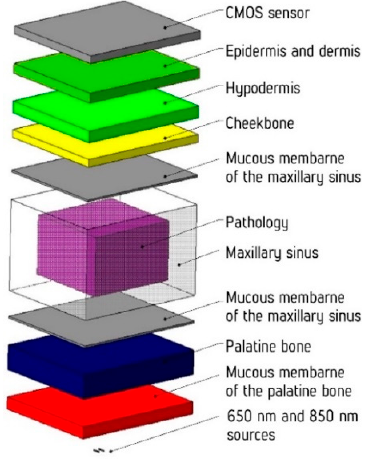
Figure 5. Full 3D view of the developed model.